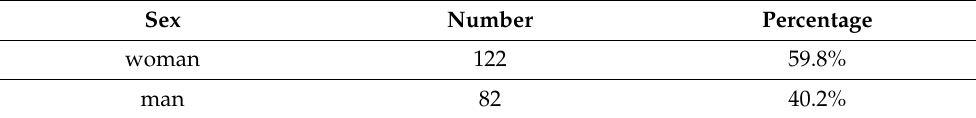
Table 2. Division according to